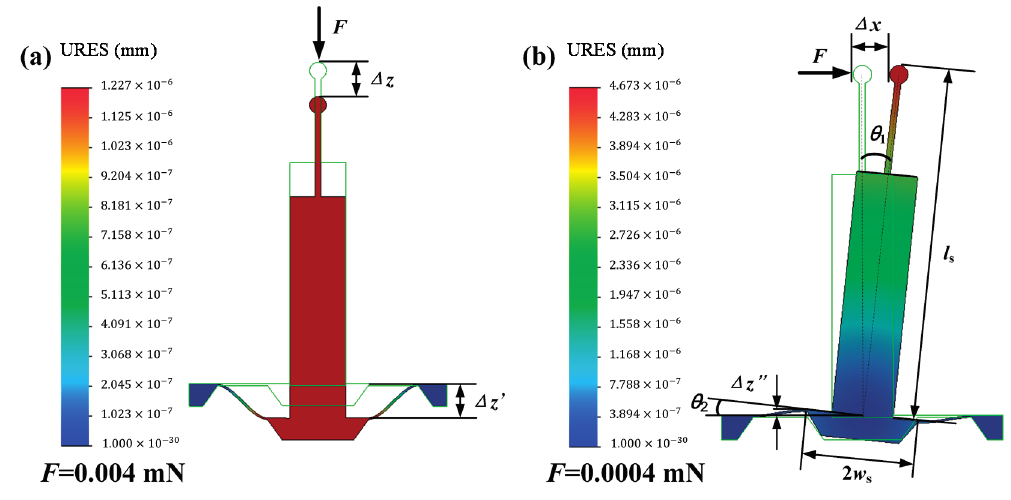
Figure 2. Displacement detection model. ( a ) Axial displacement; ( b ) Lateral